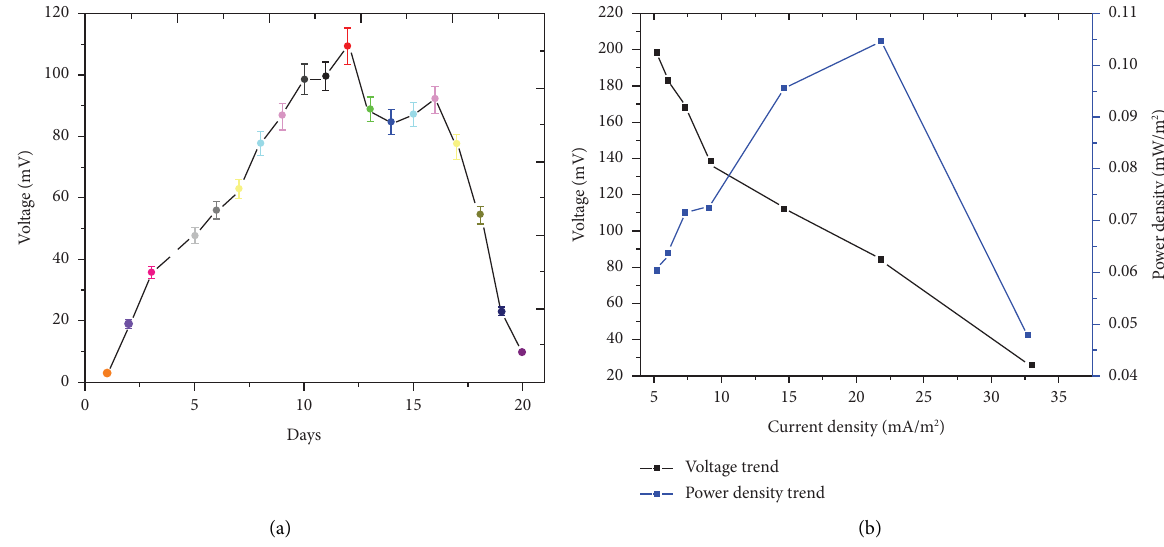
Figure 2: Recorded (a) voltage trend and (b) polarization behaviour.